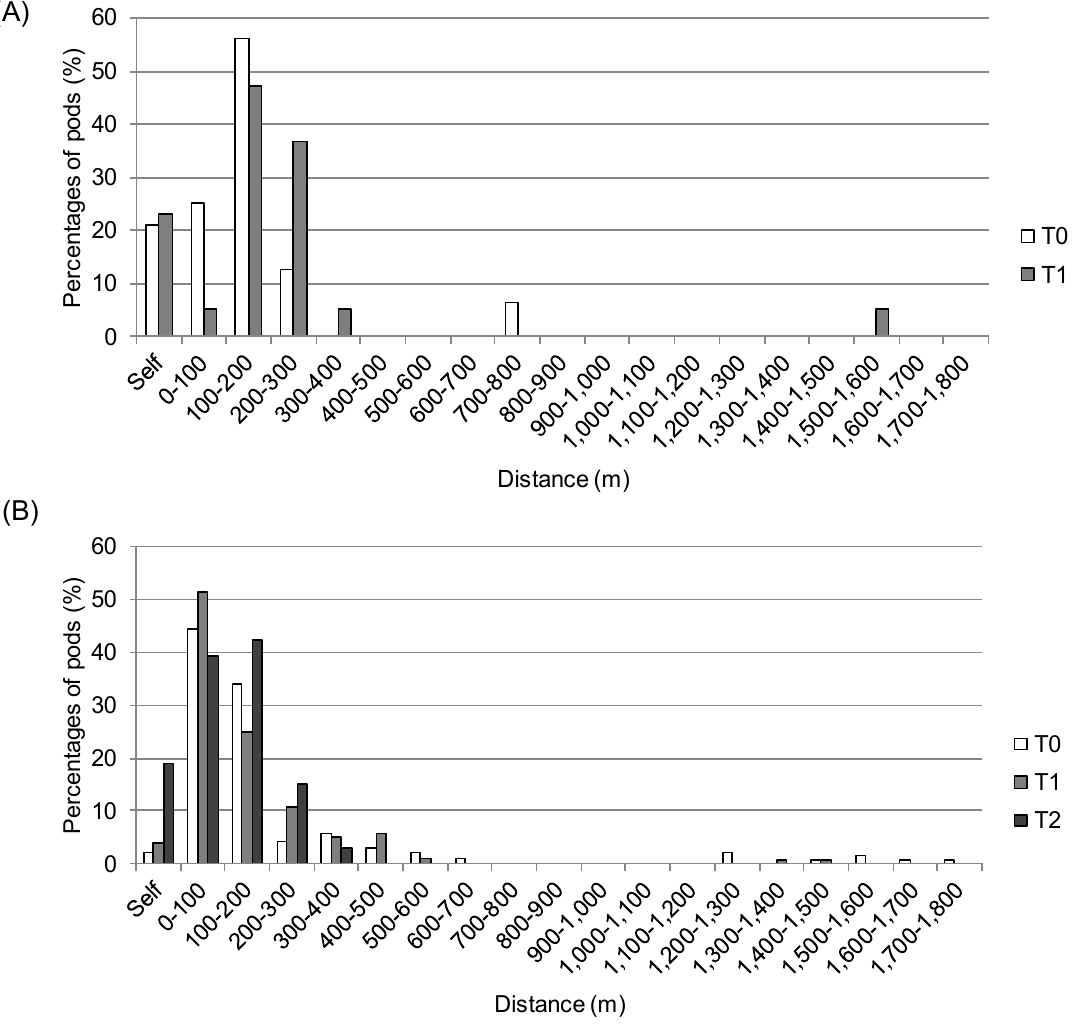
F IGURE 2. Percentages of self-pollination and distances of cross-pollen transport from donor tree to mother-tree in Parkia biglobosa divided on treatments and study sites (A) Tiba (drier site); (B), Pinyiri (more humid